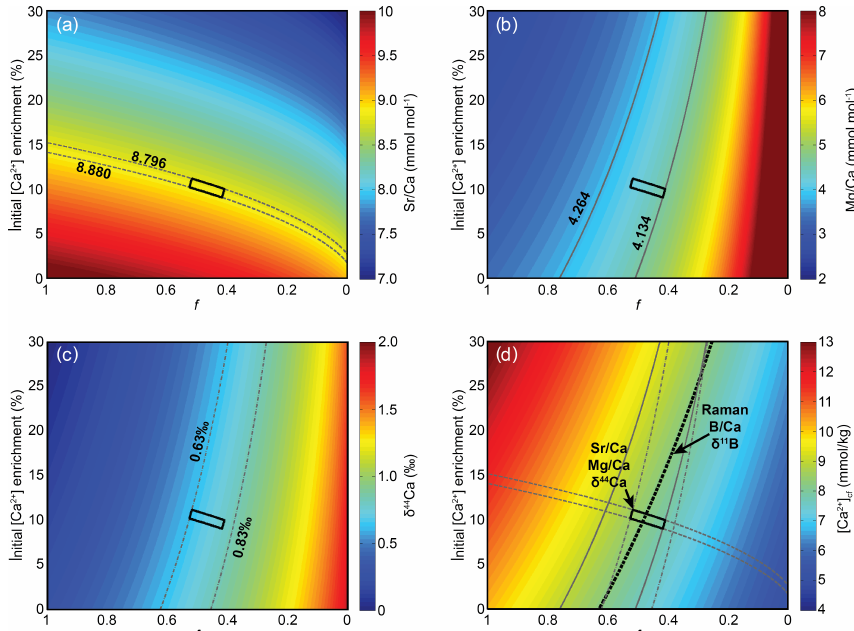
Figure 6. Evaluation of Raman-derived (cid:127) Ar based on geochemistry of the JCp-1 coral. In each panel, the x axis f is fraction of total [Ca 2 + ] cf remaining, and the y axis is initial [Ca 2 + ] cf enrichment relative to seawater. Colours indicate calculated (a) skeletal Sr / Ca, (b) skeletal Mg / Ca, (c) skeletal δ 44 Ca, and (d) [Ca 2 + ] cf . In (a–c) the grey lines bound the reported values of JCp-1 ( ± 1 σ ), and the black polygon shows the parameter space consistent with Sr / Ca, Mg / Ca, and δ 44 Ca. Panel (d) shows [Ca 2 + ] cf and the grey lines show the constraints from panels (a–c) . The dashed black line indicates the [Ca 2 + ] cf independently estimated based on combining our Raman data with published boron data (see text for details of the calculations). The two approaches are within error (i.e. the dashed black line intersects the solid black polygon) for Raman-derived (cid:127) Ar between 10.8 and 13.7, consistent with the observed (cid:127) Ar of 12.3 ±